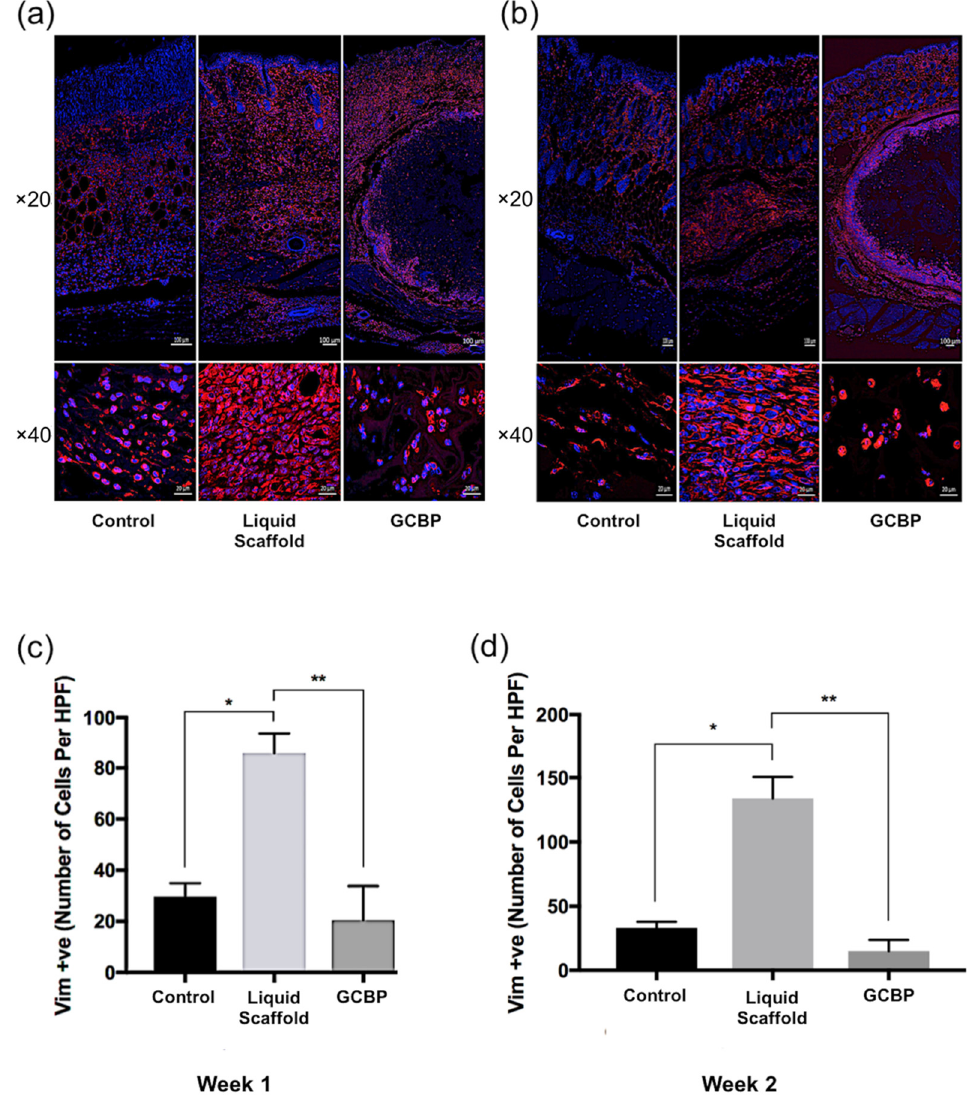
Figure 4. ( a ) Immunofluorescence staining of Vimentin-positive cells (red), counterstained with nuclear stain DAPI (blue) after 1 week. ( b ) IF staining of Vim+ cells after 2 weeks. ( c ) Quantification of Vim+ cells after 1 week. ( d ) Quantification of Vim+ cells after 2 weeks. Vim+ cells were the most dominant cell type in all groups at all time points. Liquid Scaffold had significantly higher numbers compared to GCBP and the control group (*, p < 0.05; **, p < 0.01). Scale bars in top and bottom rows = 100 μ m and 20 μ m, respectively.